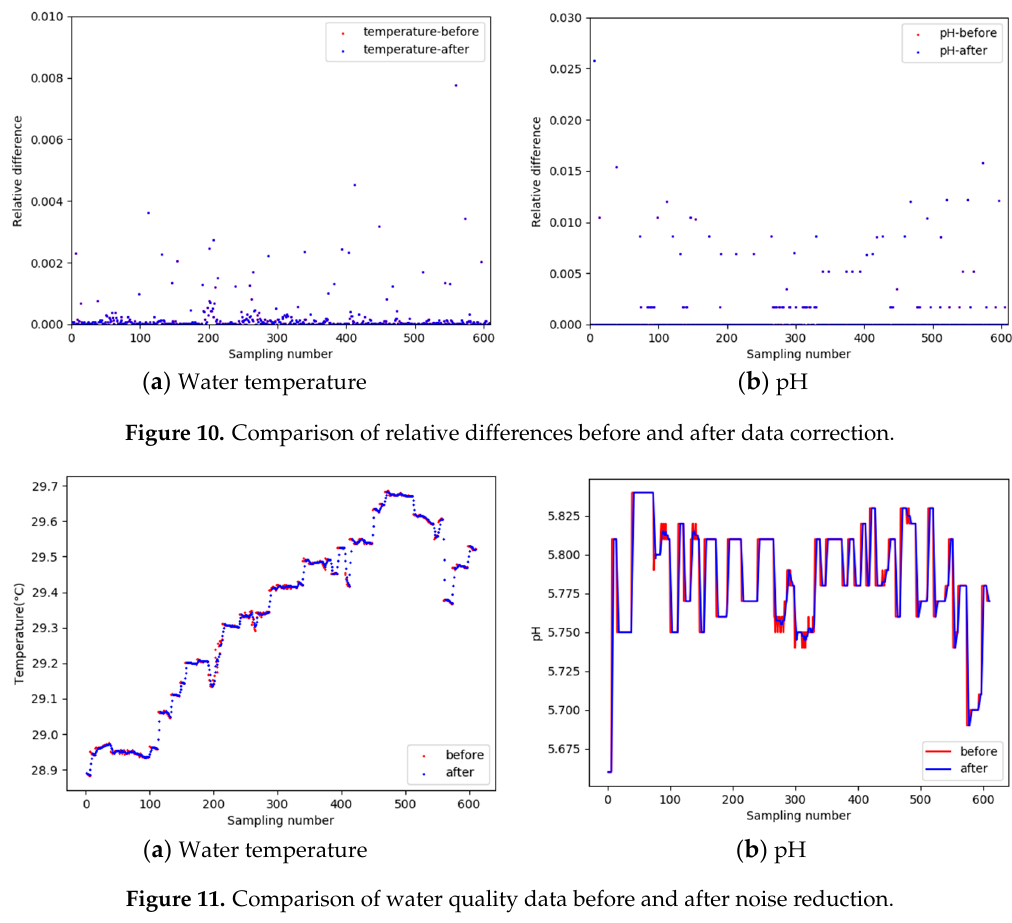
Figure 11. Comparison of water quality data before and after noise reduction.